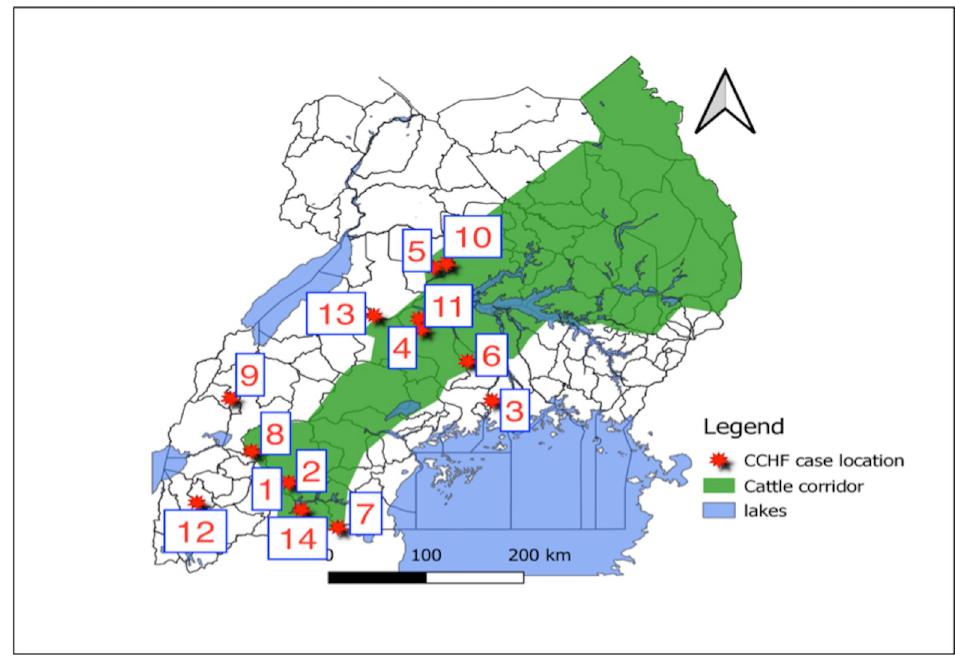
Fig 1. Distribution of Crimean-Congo haemorrhagic fever case-patients confirmed between July 2018 and January 2019, highlighting the ‘cattle corridor’ and the sequence of symptom onset of the case-patients.